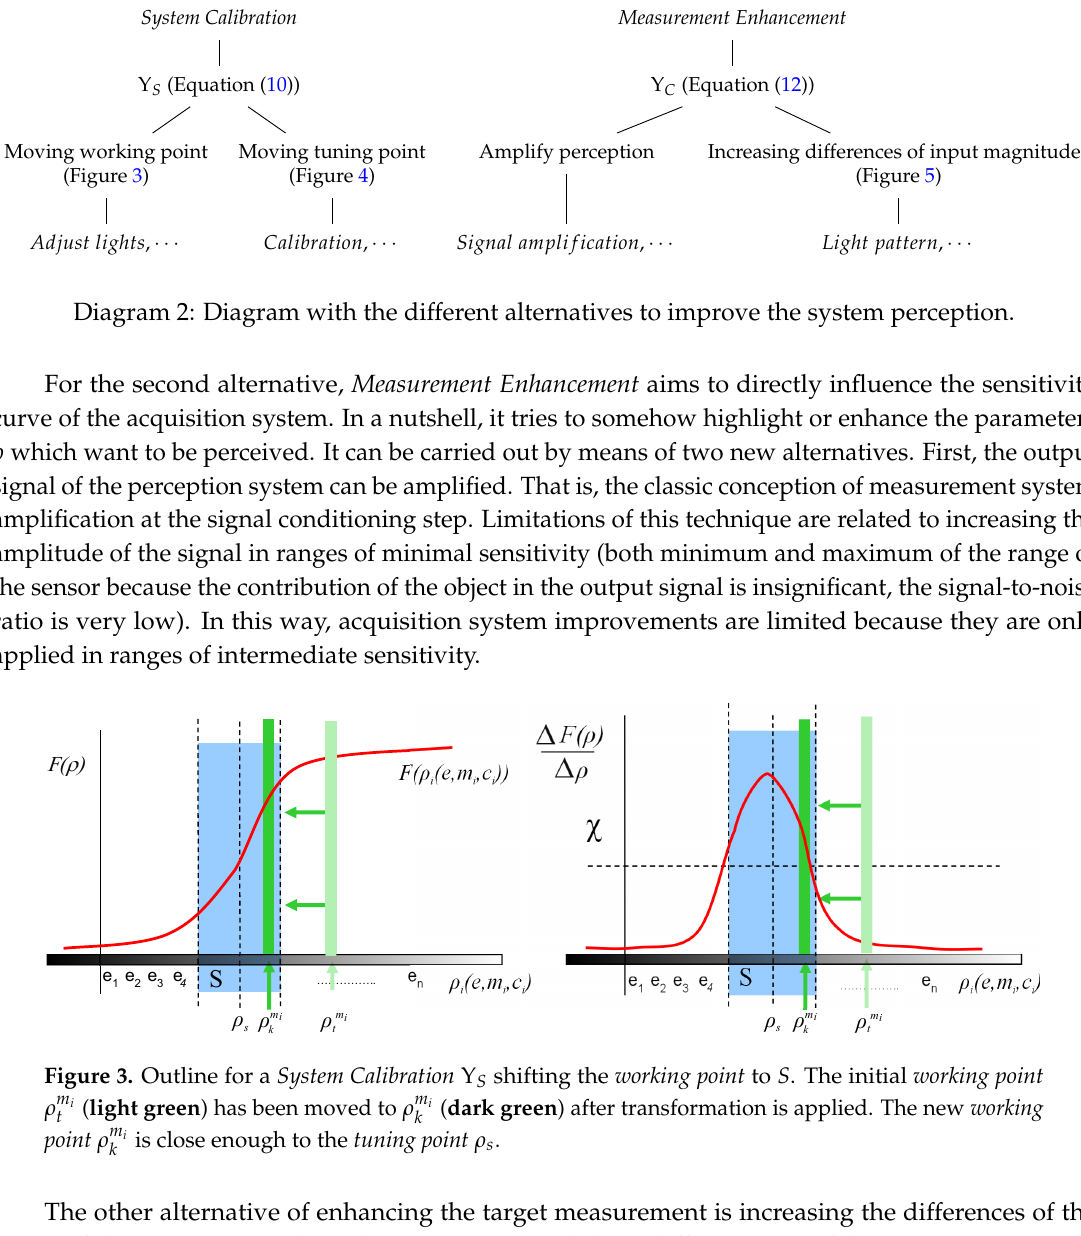
( dark green ) after transformation is applied. The new working k